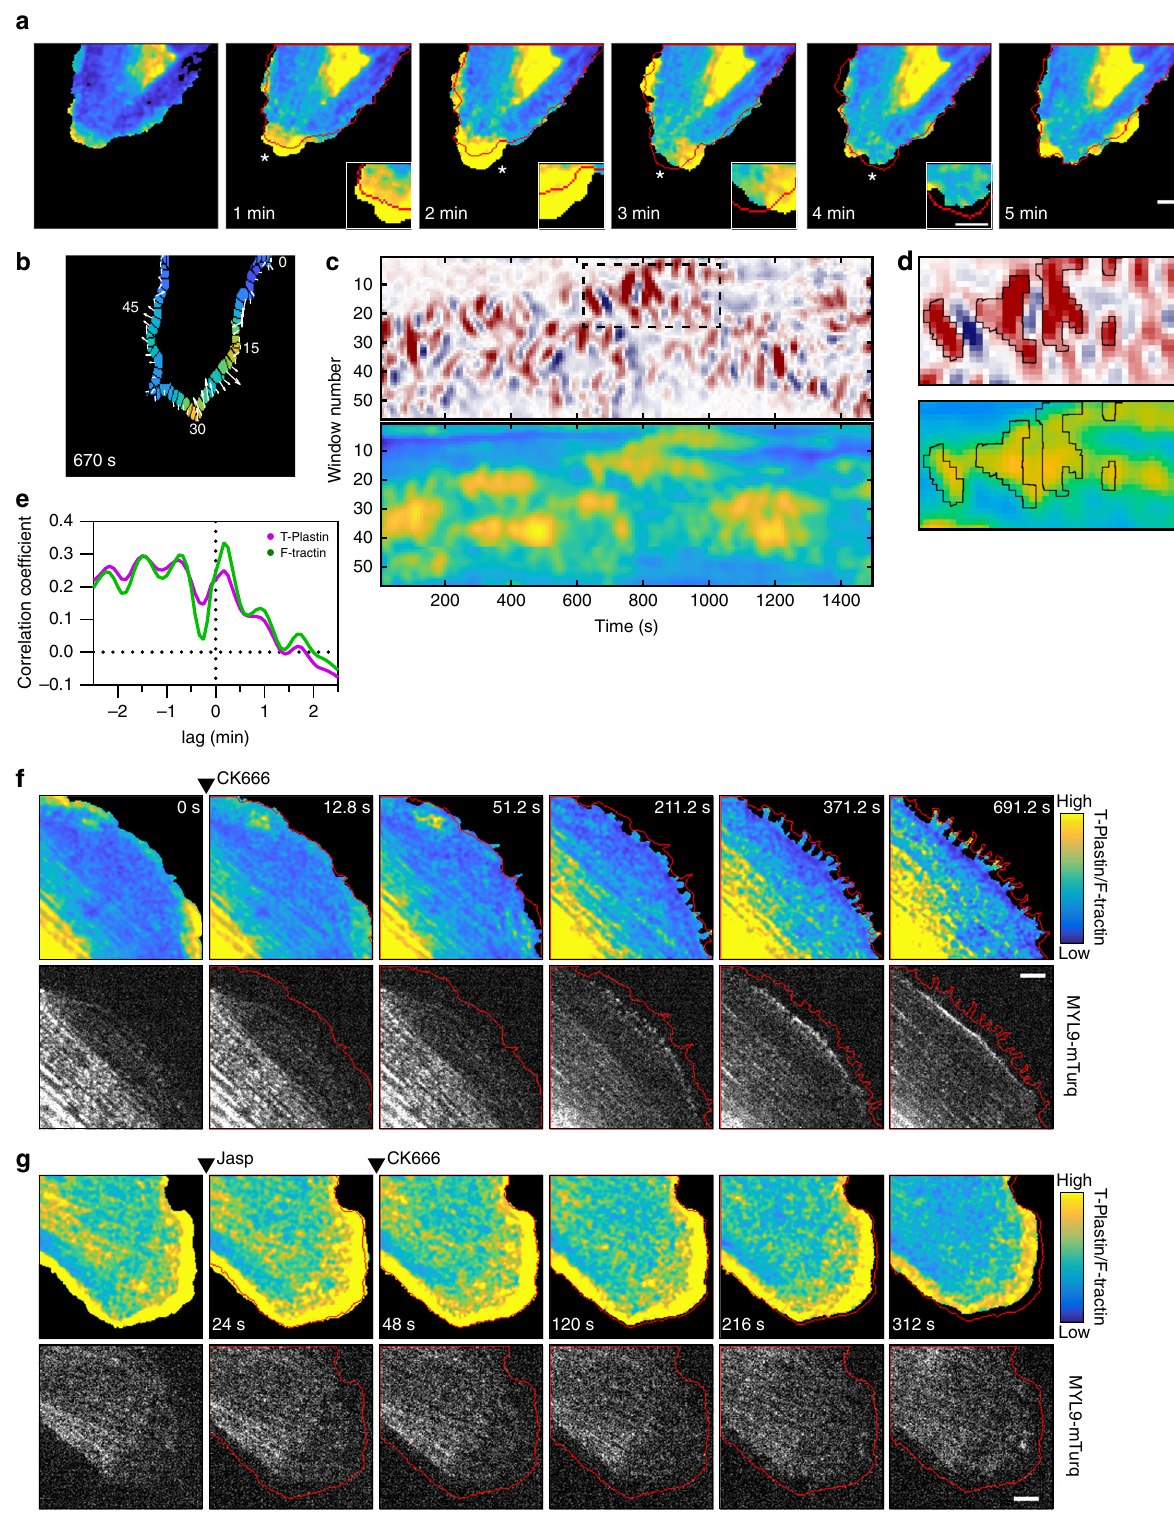
cytometry measurements of cell diameter (Fig. S4e). T-Plastin KO cells formed lamellipodial and fi lopodial protrusions (Figs. S4f and 1f, movies S1, S2, S6, and S7) and the observed focal adhesions appeared to be similar to WT cells (Figs. 5b and S4g) when spreading across non-adhesive gaps in ECM of 4 or 8 µm. However, a quantitative analysis of the degree of cell spreading on the 4 and 8 µm gapped fi bronectin ladder patterns showed